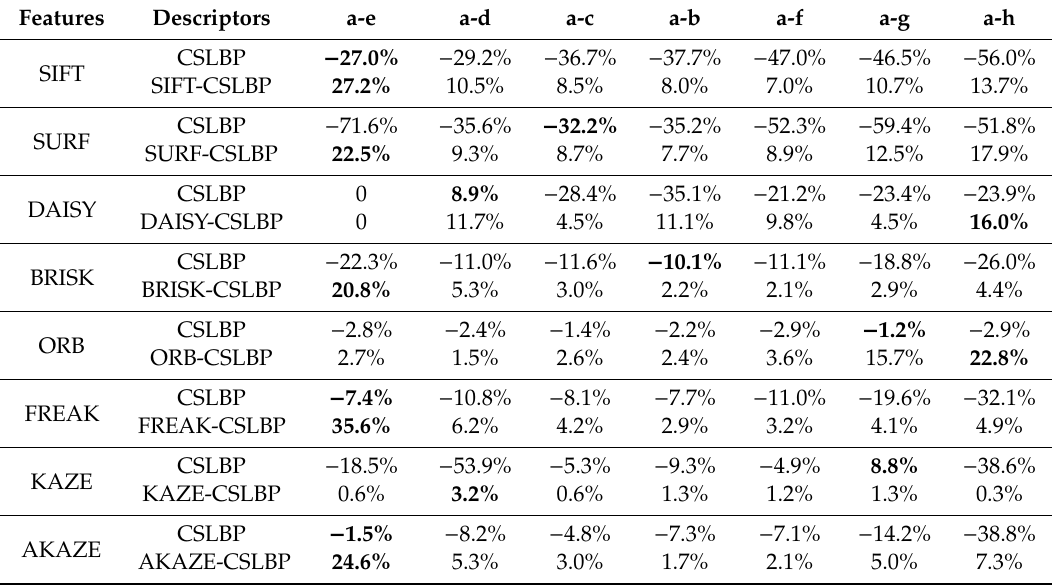
Table 10. The improved values of precision for the CSLBP and the combined descriptors compared to the original descriptors of Ubc